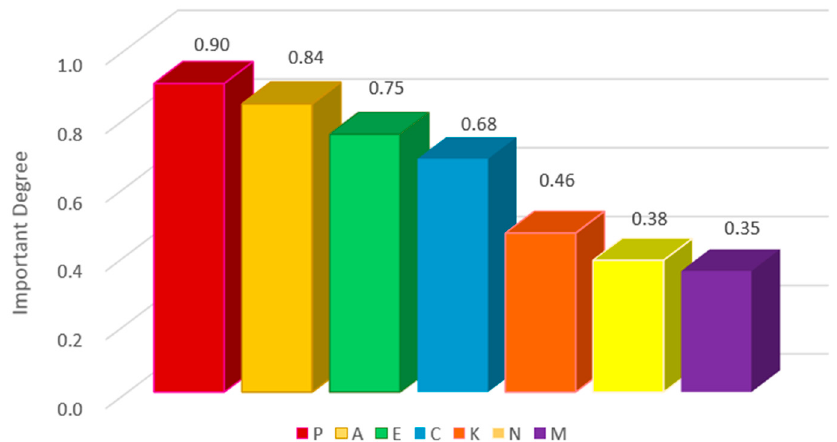
Figure 2. Distribution of degrees of importance for different features in patients.